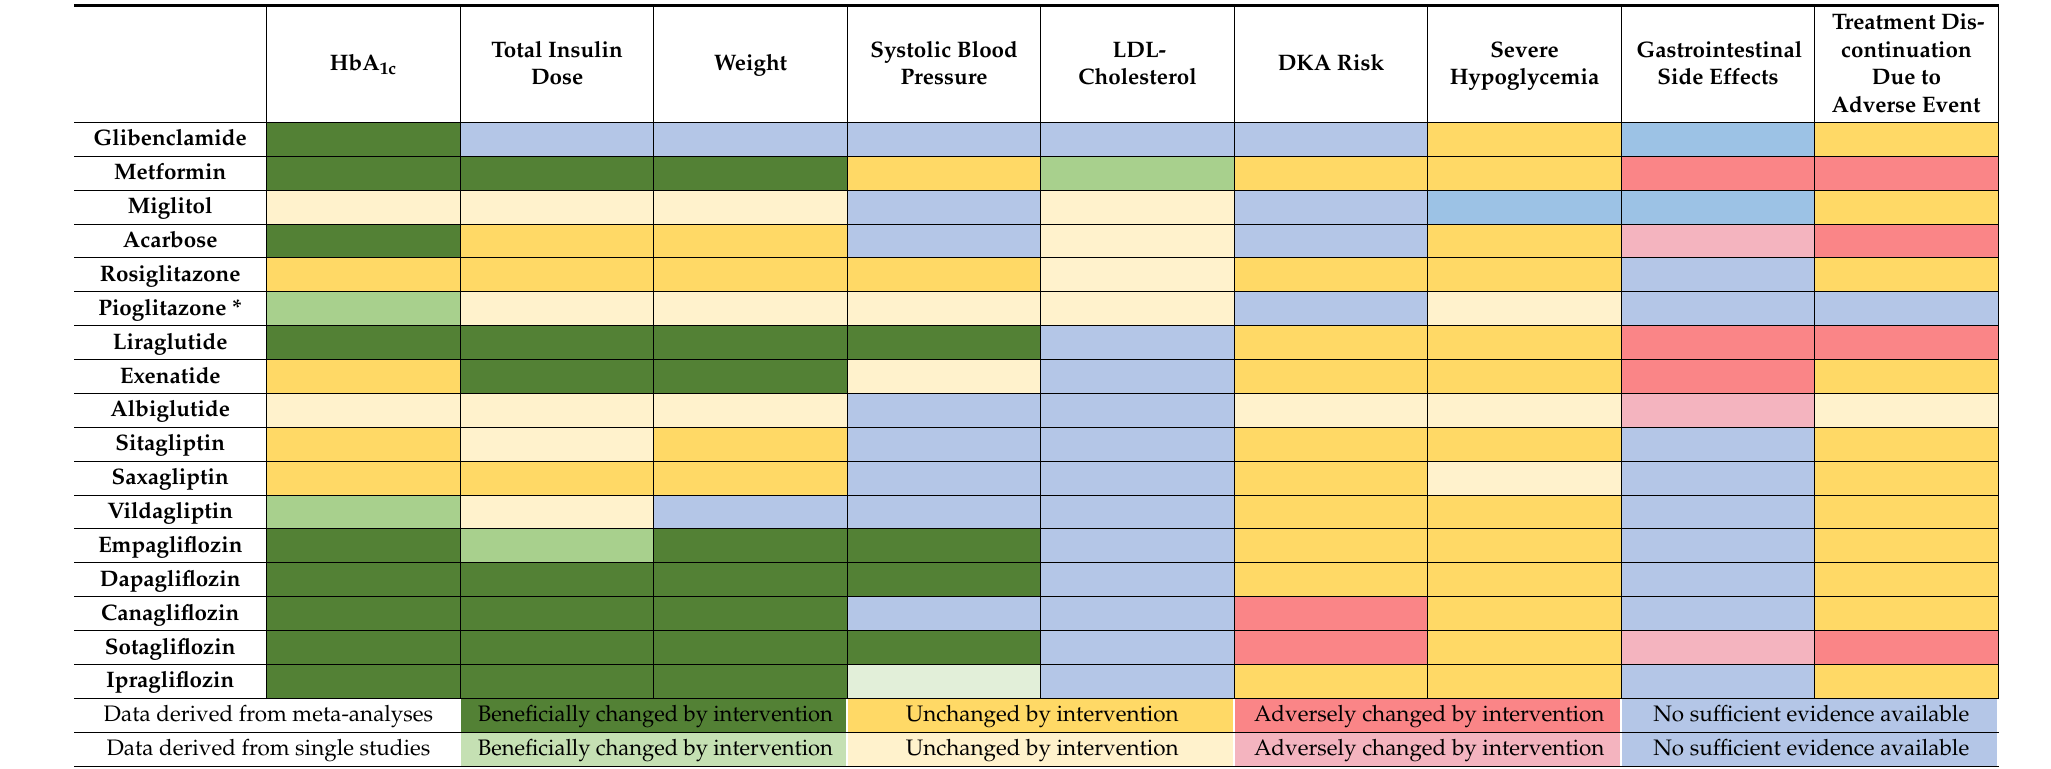
Table 2. Efficacy and safety data of non-insulin-based add-on therapies to insulin in the use in people with T1D within randomized controlled trials. The dark colors (green, yellow, red) represent evidence from meta-analyses. The light colors (green, yellow, red) indicate data derived from single studies where only little evidence is available. Blue marked boxes indicate that no evidence is available from meta-analyses or single studies. LDL-C = Low-density-lipoprotein cholesterol. * The three available pioglitazone studies were performed in